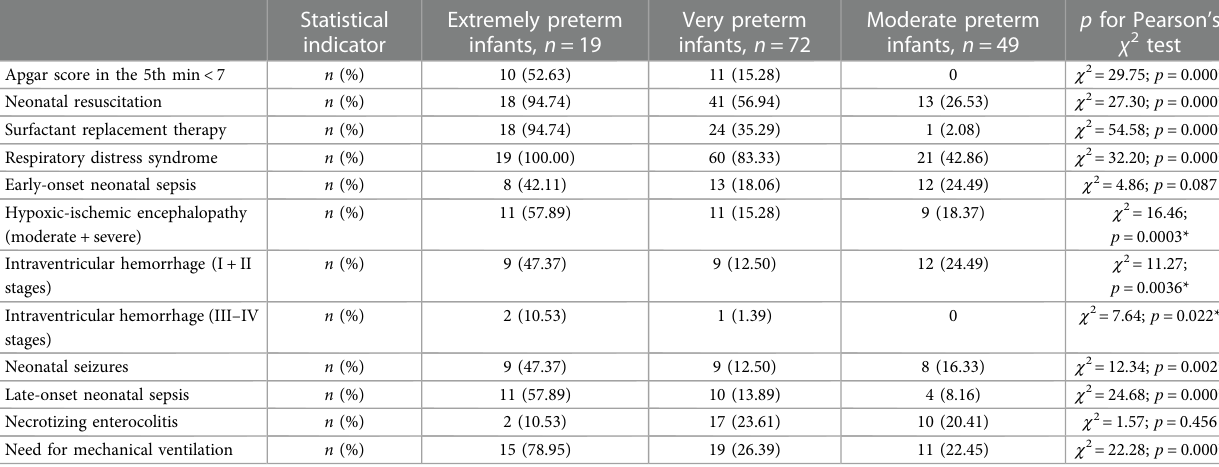
TABLE 2 Clinical characteristics of the of study population.